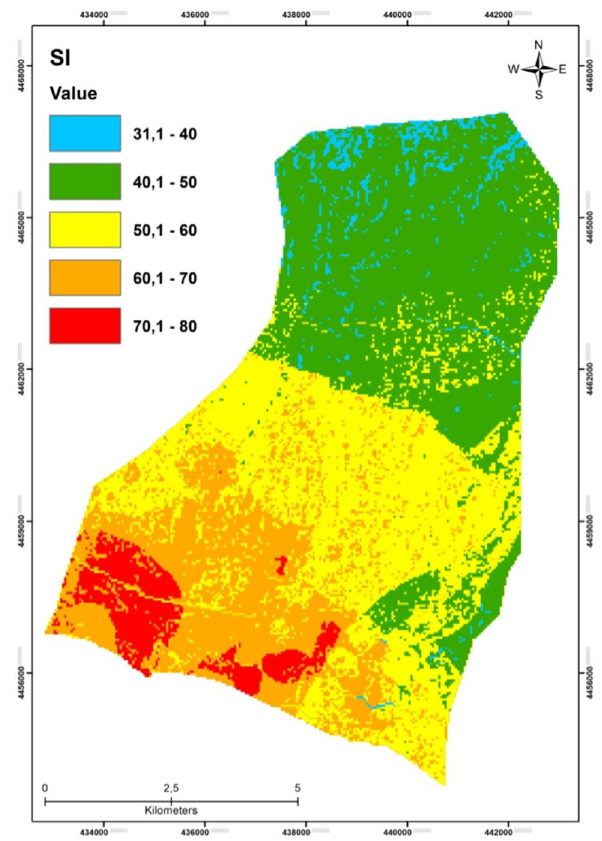
Fig. 9 SI vulnerability map